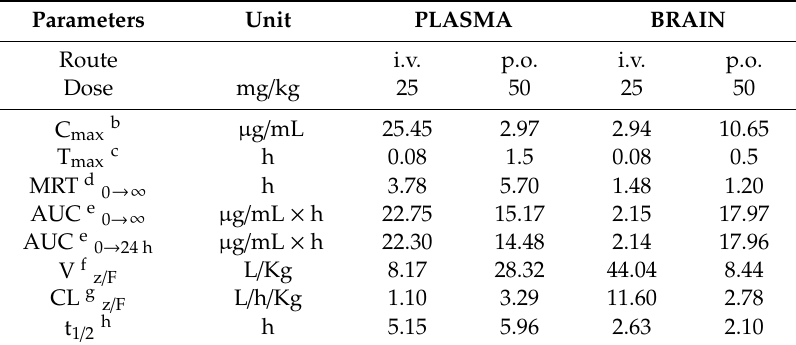
Figure7. Pharmacokineticsof Si306(mean ± S.E.M., n = 5, plasma: µ g / mL; tissues: µ g / g). ( a ) Distribution Figure 7. Pharmacokinetics of Si306 (mean ± S.E.M . , n = 5, plasma: µg/mL; tissues: µg/g). ( a ) inmicetissuesafteri.v. administrationover24h. ( b )Distributioninmicetissuesafterp.o. administration Distribution in mice tissues after i.v. administration over 24 h. ( b ) Distribution in mice tissues after over 24 h. p.o. administration over 24 h. Table 6. Plasma and brain pharmacokinetic parameters for Si306 Table 6. Plasma and brain pharmacokinetic parameters for Si306 a.